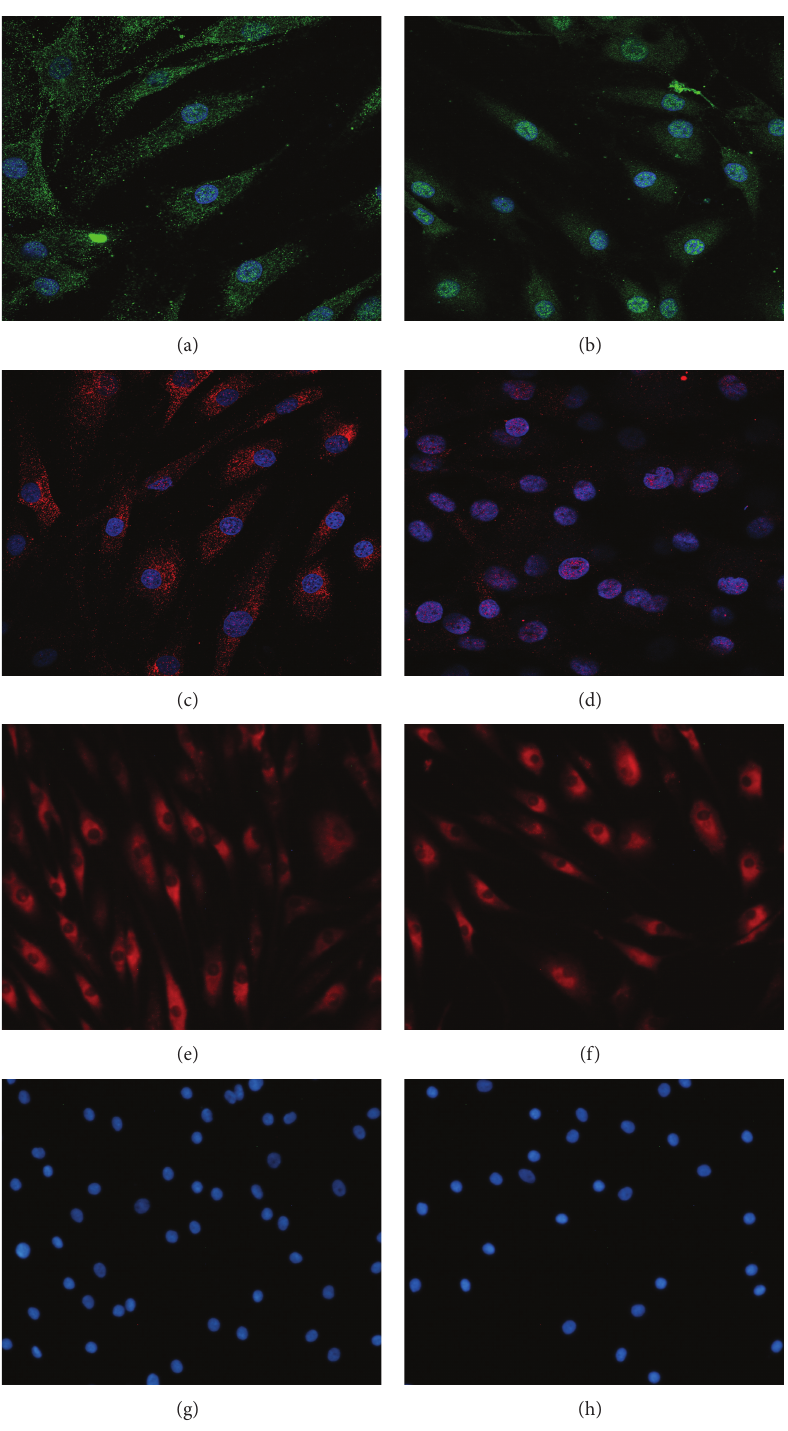
Figure 4: Detection of protein expression of Shh signaling pathway related components in cultured FLS from RA patients by cell immunofluorescence assay ( × 200). Expression of Shh (a), Ptch1 (b), Smo (c), and Gli1 (d) protein was observed using laser confocal microscopy. Smo was assayed by fluorescence microscopy ((e), (f)). After treatment with cyclopamine (10 𝜇 mol/L) for 48 hours, there were considerably fewer cells expressing Smo (f) compared to the control group (e). (g) and (h) show a nuclear stain of the same field as (e) and